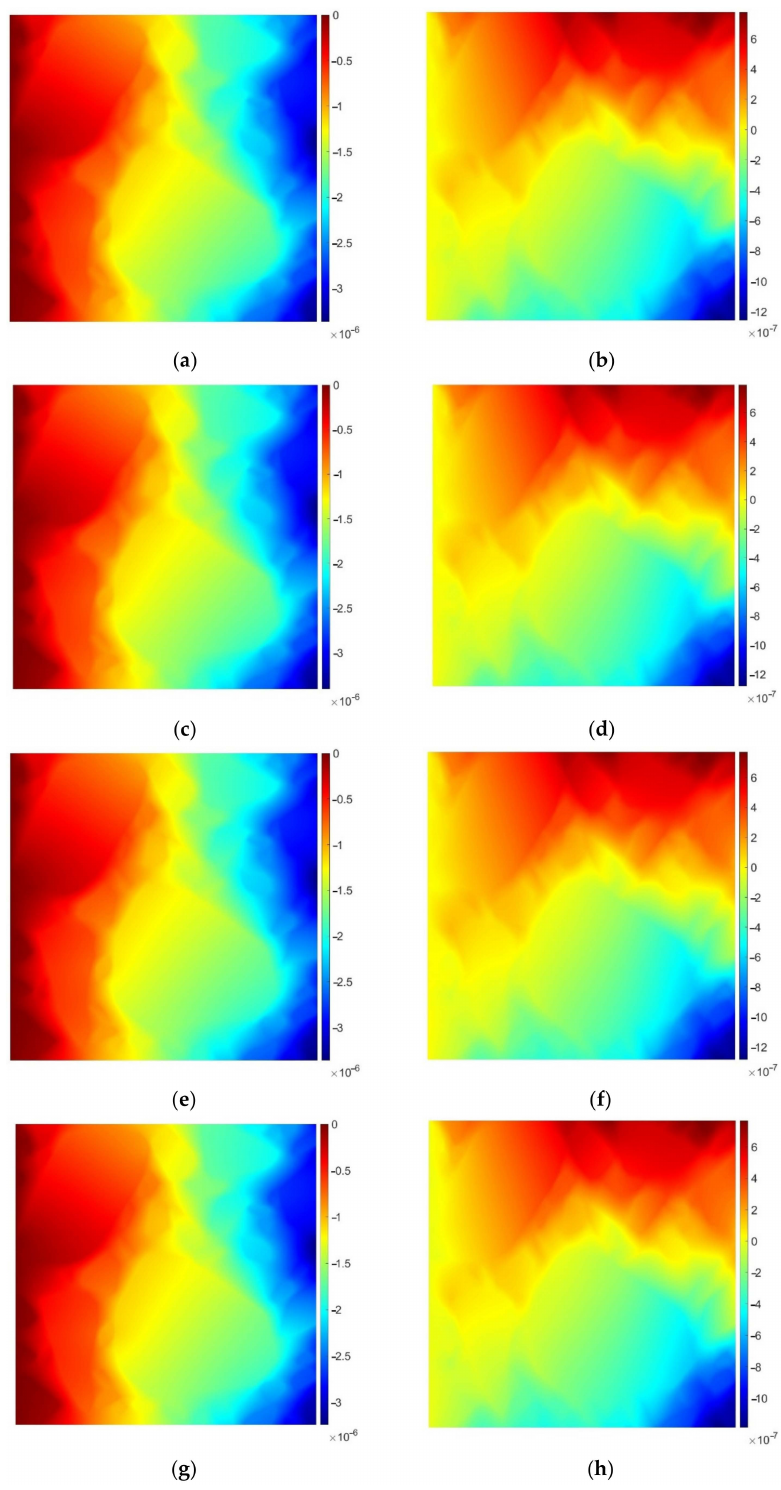
Figure 11. Horizontal ( a , c , e , g ) and vertical ( b , d , f , h ) displacement components [m]. The first row presents the reference solution and the remaining ones refer to the geometries obtained us- ing the shortest edge elimination, the local geometry enhancement and the convex subdomain approach,